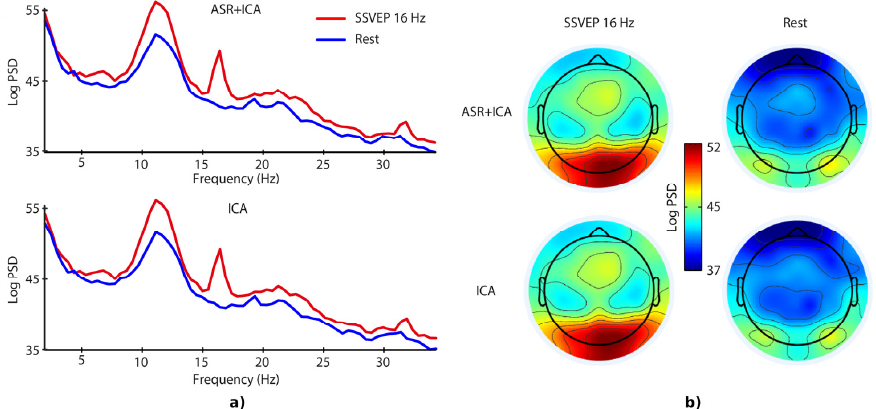
Figure 4. Results of visual stimulation (SSVEP) and rest conditions: ( a ) power spectrum density (log10) from channel Oz; ( b ) maps of 16 Hz frequency distribution on the skull (the upper part of the figure presents ASR and the lower part represents the ICA condition).